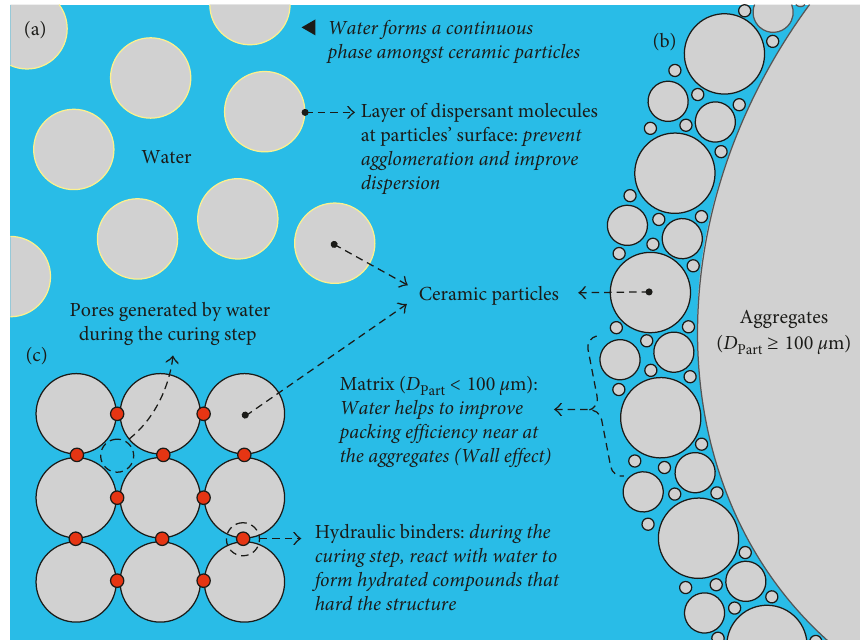
Figure 1: Roles of water in the preparation of ceramic particles suspensions: (a) it is a continuous medium for particle dispersion, (b) it improves particle packing through the Wall effect, and (c) it reacts with a hydraulic binder to strengthen the